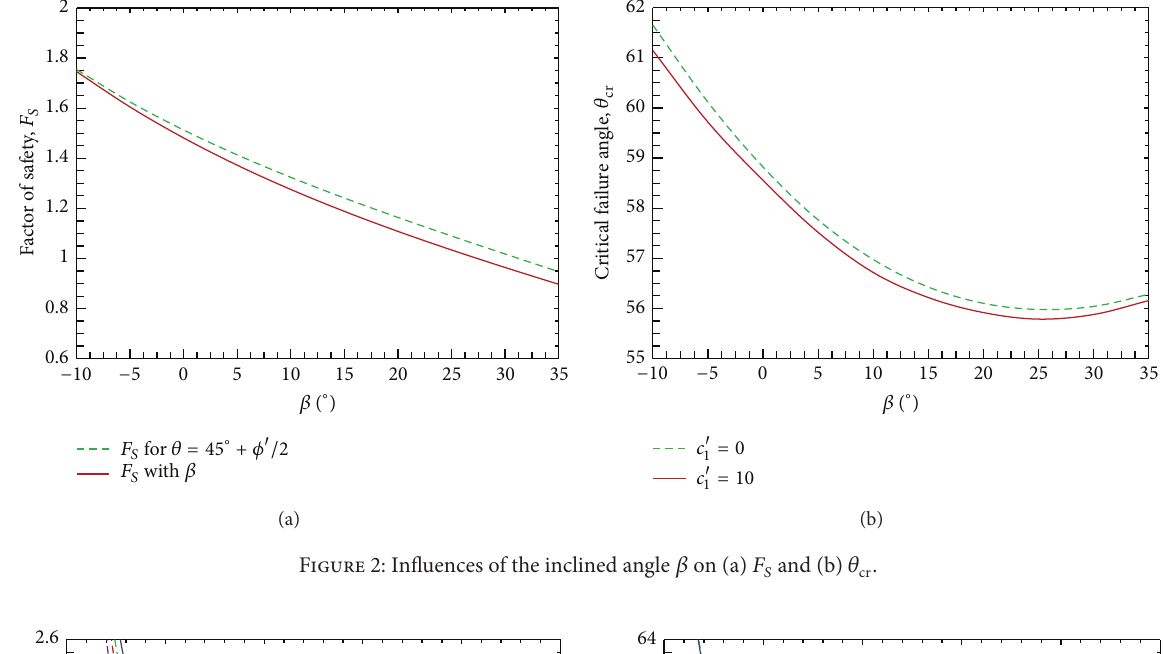
Figure 2: Influences of the inclined angle 𝛽 on (a) 𝐹 𝑆 and (b) 𝜃 cr .